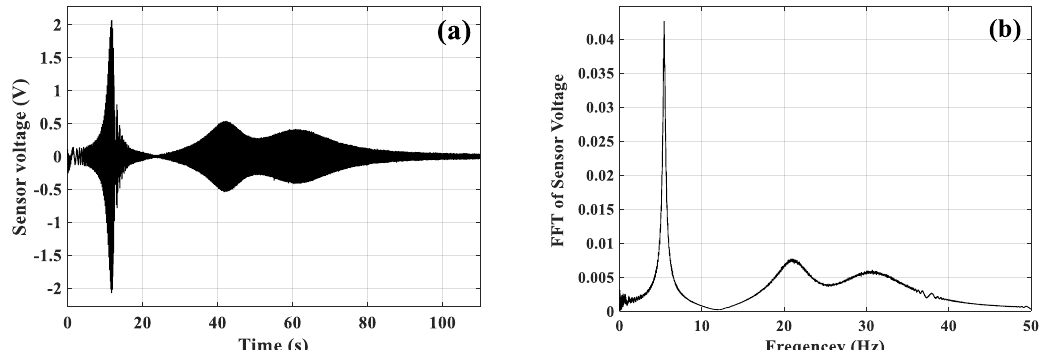
Figure 18. Measured vibration responses excited by actuator a : ( a ) Time-domain responses of sensor a , ( b ) frequency responses of sensor a .